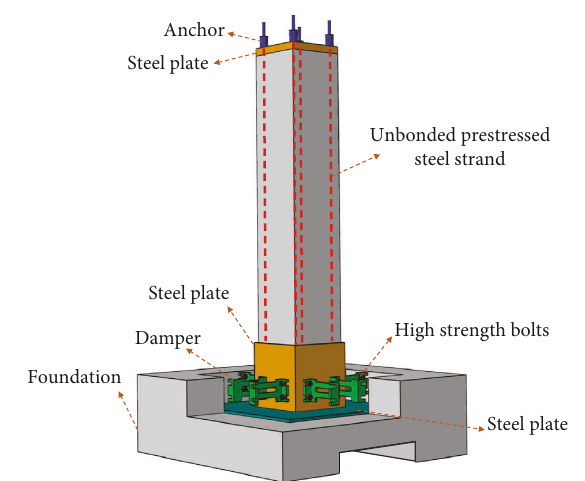
Figure 1: The schematic in detail of the RED-HRC joint with RC